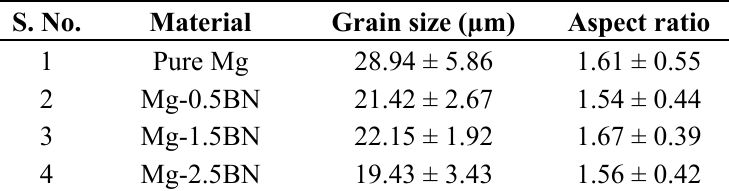
Table 2. Results of grain size